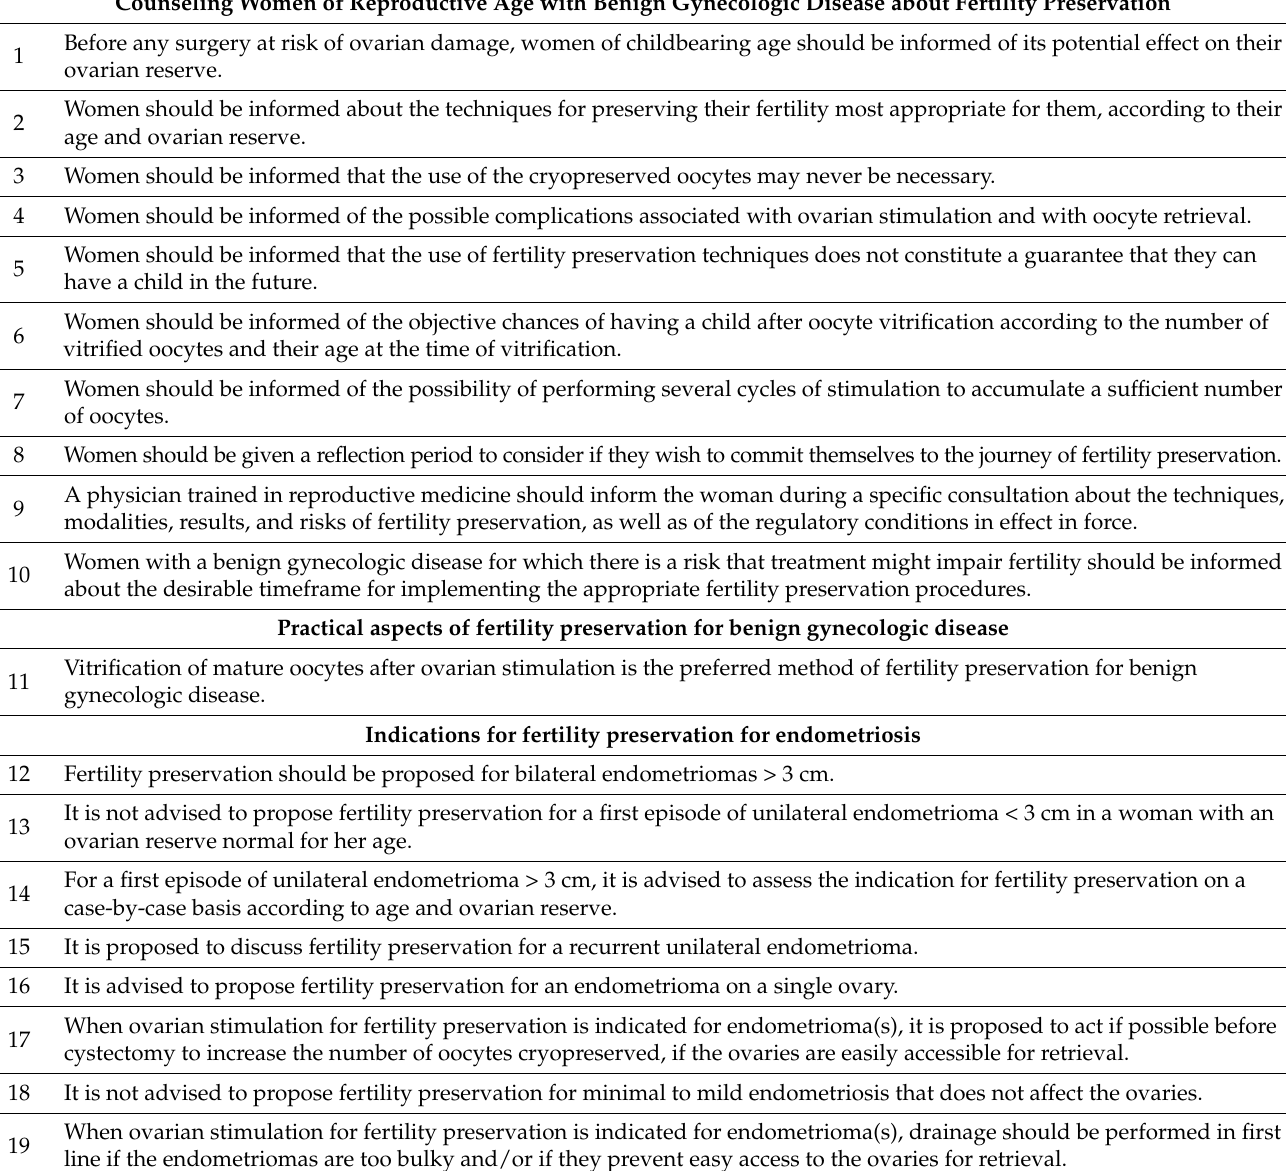
Table 2. Final set of French clinical guidelines defining indications for oocyte vitrification for fertility preservation in women with benign gynecologic